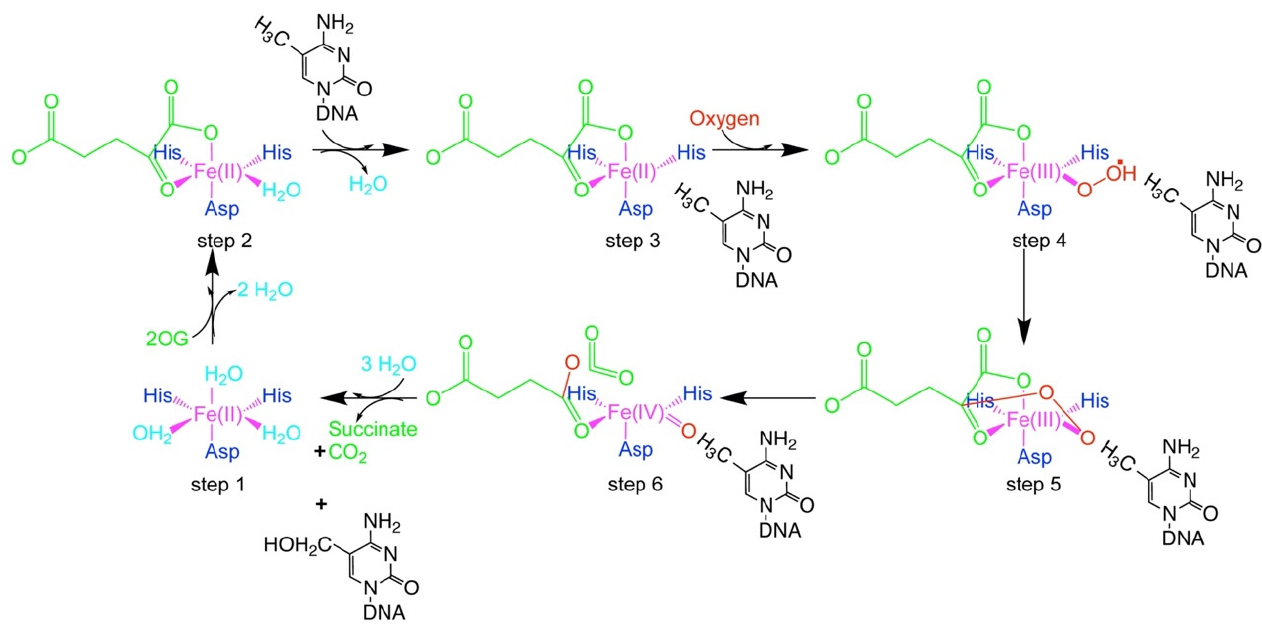
Figure 5. Mechanism of action of Fe(II)/2OG-dependent